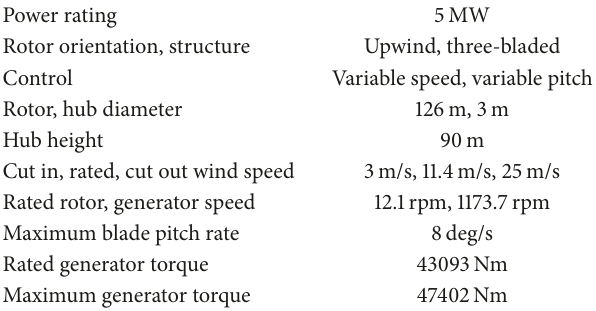
Table 1: Parameters of NREL’s 5 MW wind turbine model.